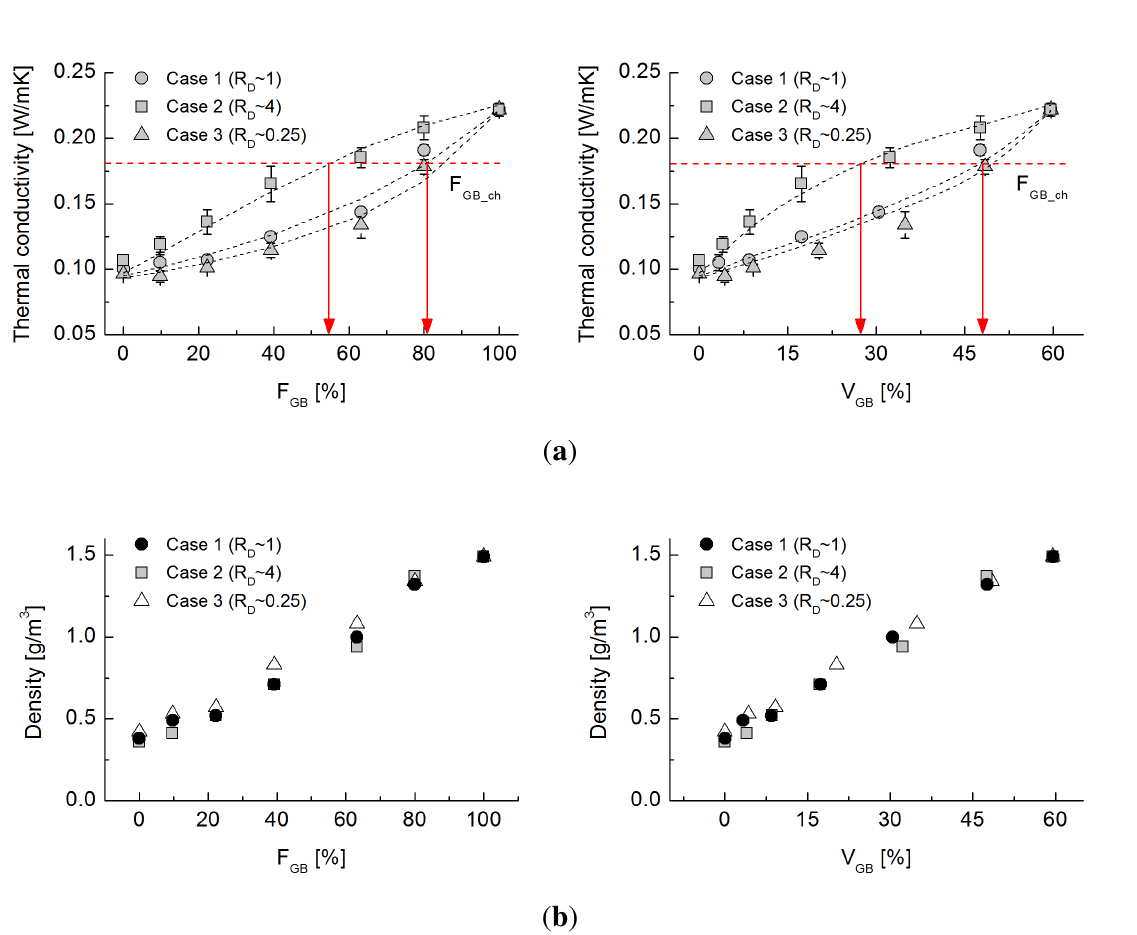
Figure 4. ( a ) Evolution of thermal conductivity values with varying volumetric fractions of glass beads for Cases 1 to 3; ( b ) density values with varying volumetric fractions of glass beads for Cases 1 to